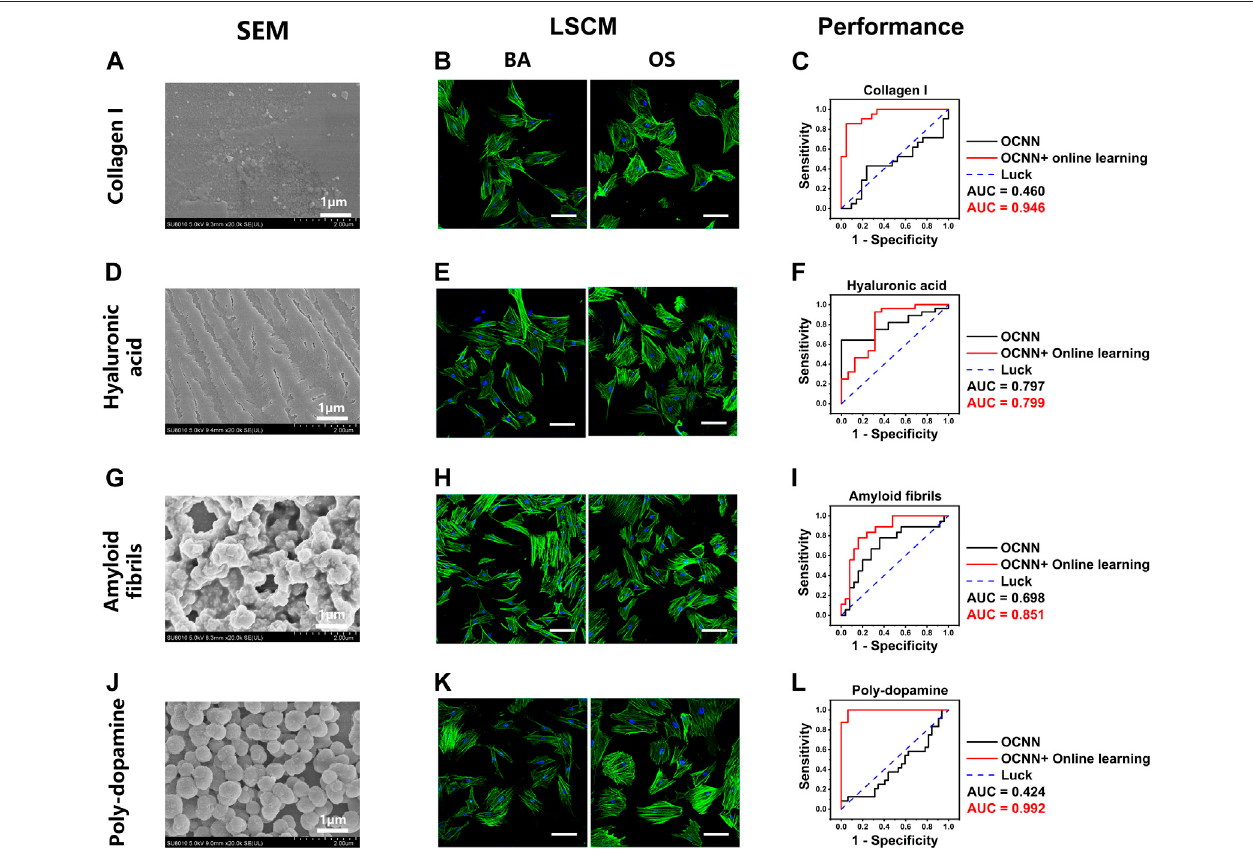
FIGURE 6 | OCNN prediction and OCNN-based online learning for rBMSCs on chemical coatings. (A) (D) (G) (J) SEM images of four different chemical coatings: collagenI,hyaluronicacid,amyloid fi brils,andpoly-dopamine,scalebar (cid:1) 1 µm. (B)(E)(H)(K) LSCMimagesoftherBMSCsonfourdifferentchemicalcoatings:collagen I, hyaluronic acid, amyloid fi brils, and poly-dopamine. Basal medium (BA), osteogenic supplement medium (OS). Induction time: 24 h; green: F-actin; blue: nuclei. Scale bar, 100 µm. (C) (F) (I) (L) Comparison of the OCNN prediction and OCNN-based online learning results using ROC curves. Black line: OCNN prediction and red line: OCNN accompanied with online